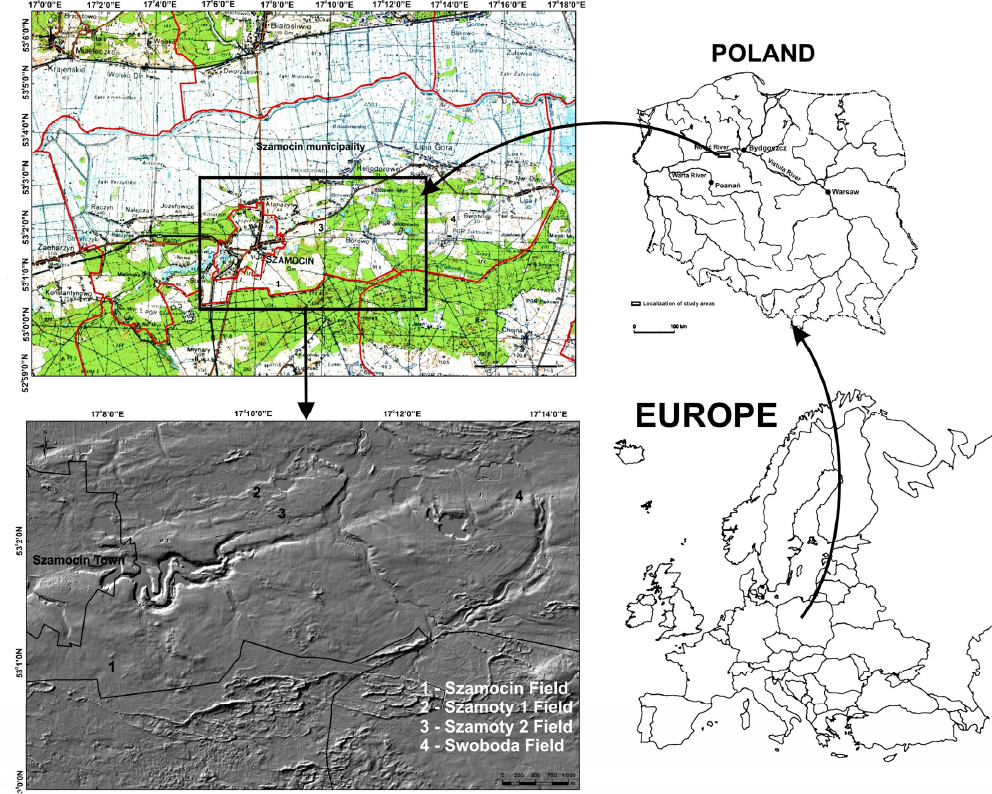
Figure 1. Research area location against the background of the map of Poland and Europe. The reach of respective aeolian covers was marked using GPS RTK (Real Time